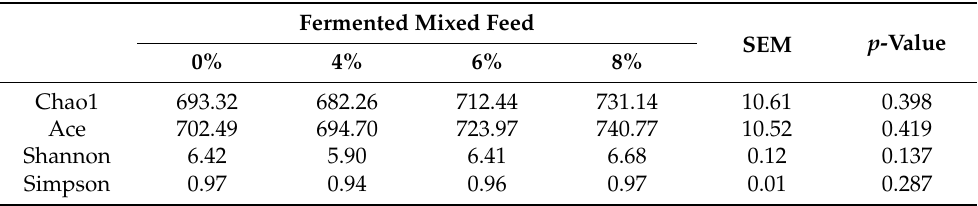
Table 5. Effect of fermented mixed feed on α -diversity of cecal microflora in